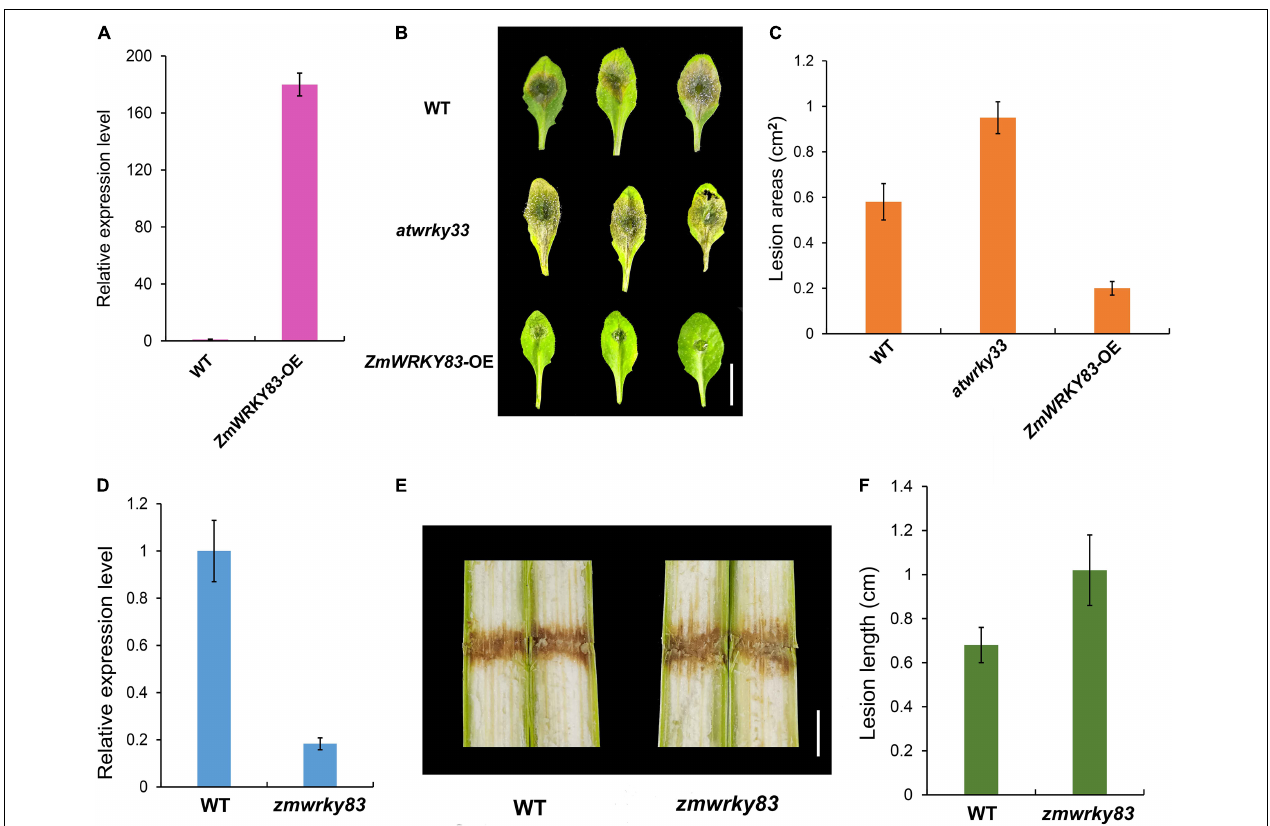
FIGURE 8 | ZmWRKY83 overexpression in transgenic Arabidopsis increases B. cinerea resistance. (A) The relative expression level of ZmWRKY83 in Col-0 and ZmWRKY83 overexpressing transgenic plants. (B) Altered disease resistance of Col-0, atwrky33 mutant, and ZmWRKY83 overexpressing transgenic plants against B. cinerea . Four-week-old plants were inoculated by B. cinerea spore suspension (10 6 ml − 1 ) and kept at high humidity. The experiments were repeated three times with similar results. (C) Measurement of lesion areas on B. cinerea -inoculated Arabidopsis leaves shown in panel B . The necrotic lesion areas on each leaf were measured using ImageJ. Data represent the mean ± SD. (D) The relative expression level of ZmWRKY83 in B73 and zmwrky83 mutant. (E) Altered disease resistance of B73, zmwrky33 mutant against F. graminearum . V7 stage plants were inoculated by F. graminearum spore suspension (10 6 ml − 1 ) and kept at high humidity. (F) Measurement of lesion length on F. graminearum -inoculated maize stem shown in panel E . Data represent the mean ±